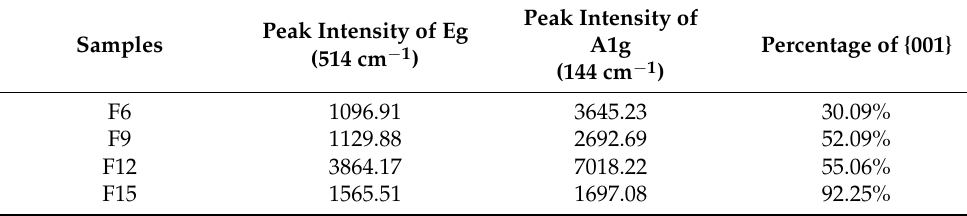
Table 1. Peak intensity and the ratio of the Raman vibrational modes between Eg and A1g.